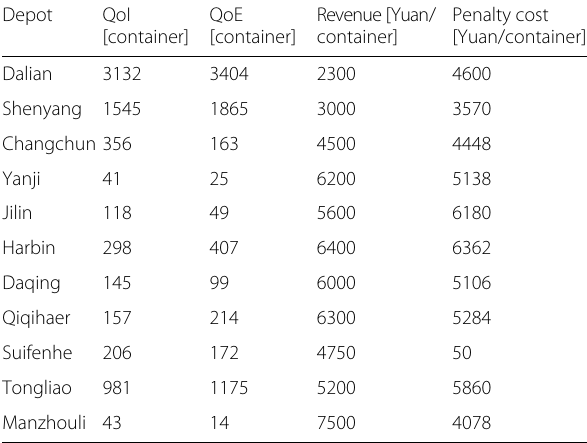
Table 2 Quantity of import-containers and export-containers of each depot, unit revenue of transporting export-container from each depot to harbor, penalty cost of abandoned demand of customers at each